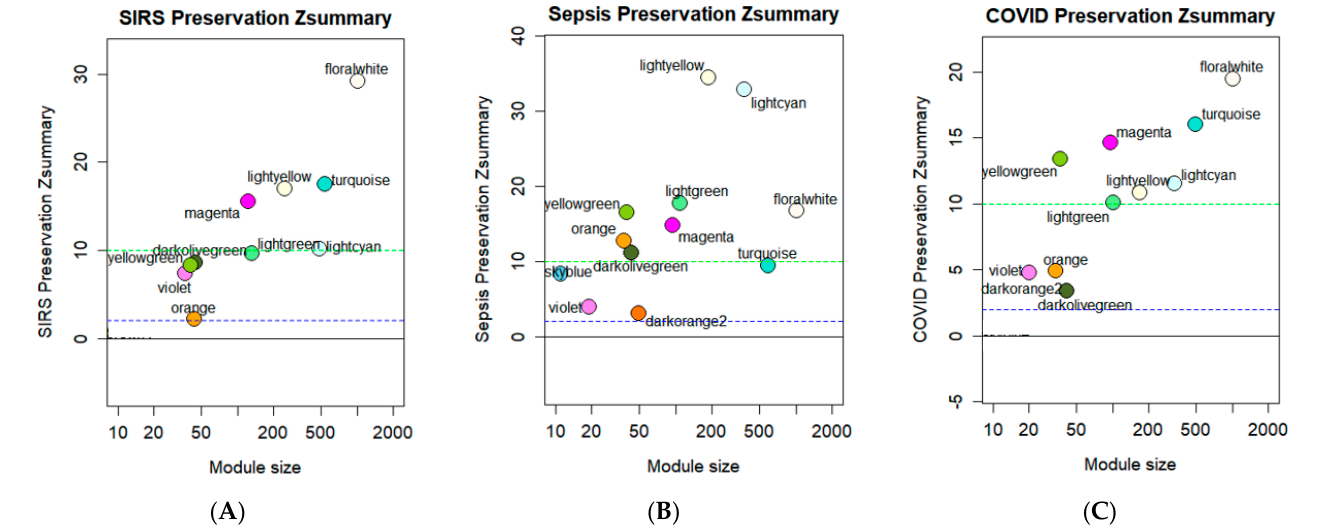
Figure 7. Module preservation analysis results highlighting the highly conserved co-expressed gene modules between SIRS ( A ), sepsis ( B ), and COVID-19 ( C ), using ARDS as reference. Summary statistic indicates -log10 statistical significance of each module. Green and dark blue dashed lines represent cut-off of strong preservation and moderate preservation, respectively.